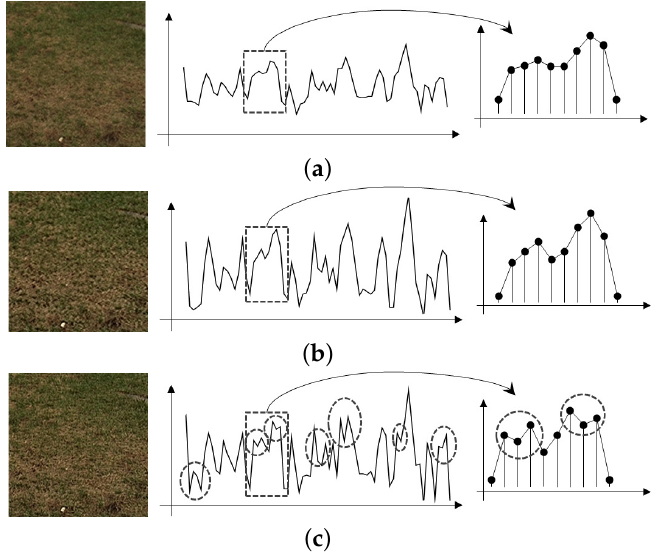
Figure 1. Effects of detail image signals. ( a ) Original image. ( b ) Image with increased local variants. ( c ) Image with increased local variants and enhanced granular